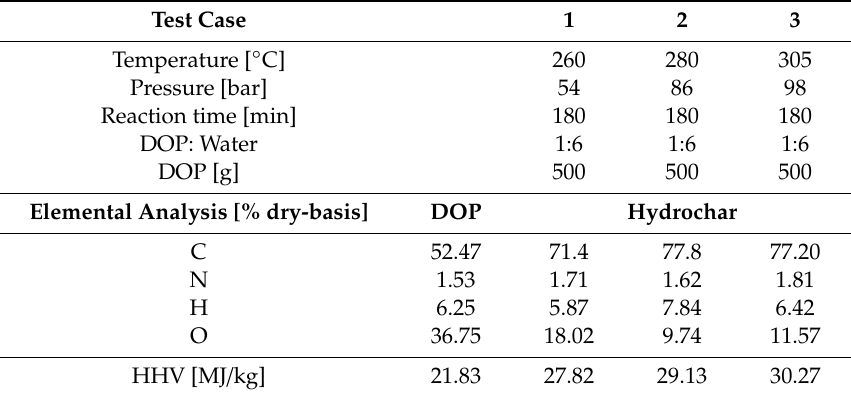
Table 1. Experimental operation conditions and characteristics of initial DOP and hydrochar produced at di ff erent temperatures [21].